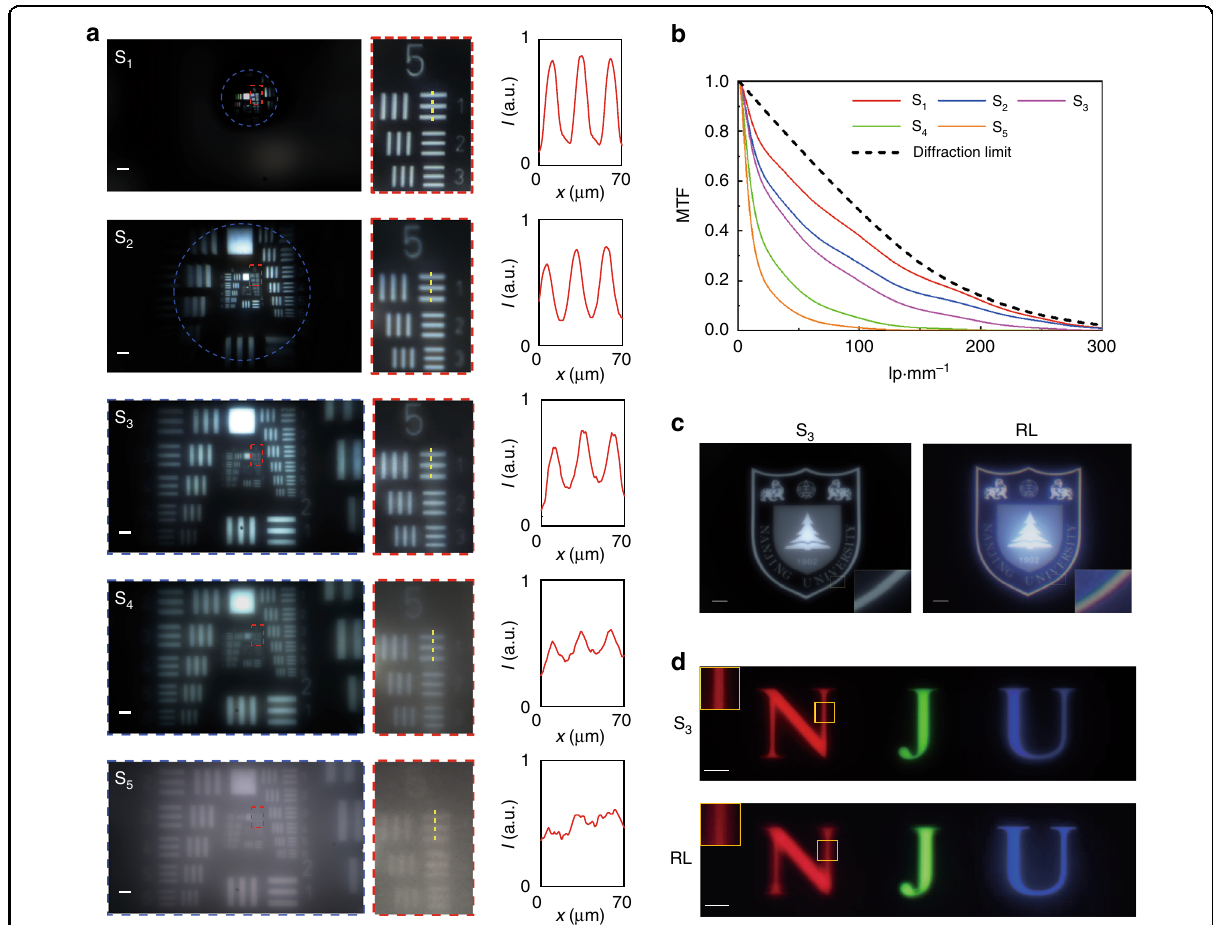
Fig. 5 Imaging performance of AMDLs. a Image results of 1951 USAF resolution test chart taken from samples S 1 ~ S 5 . The whole images captured by CCD (left column). Scale bar, 250 μ m; zoom-in images of group 5 element 1~3 (middle column); the light intensity (denoted as I) along the yellow dashed lines (right column). b The broadband MTF of samples S 1 -S 5 and diffraction limited MTF (black dashed line). c Image of Nanjing University logo taken from sample S 3 and a refractive lens. Zoom-in image shows the edge details of the logo. Scale bars, 2 mm. d Images of three colorful letters (N, J, U) taken from sample S 3 and a refractive lens. Zoom-in image shows the edge details of the letter R. Scale bars, 4